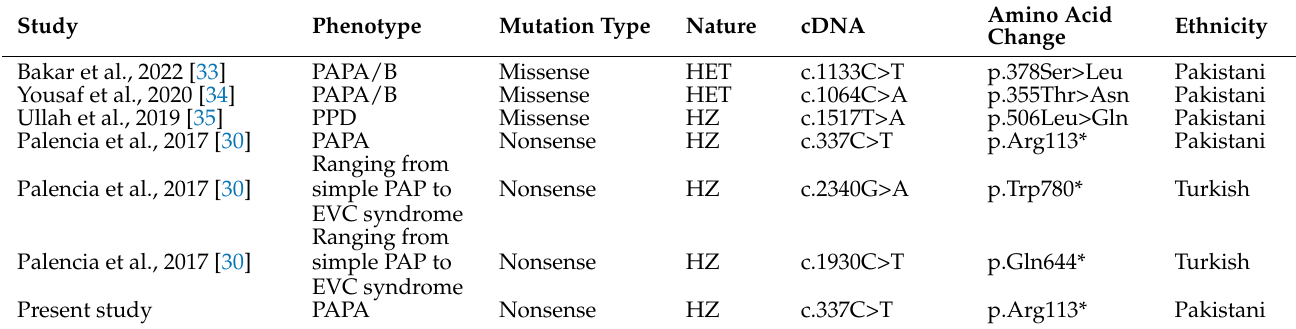
Table 5. Description of previously reported pathogenic GLI1 variants associated with PAP.